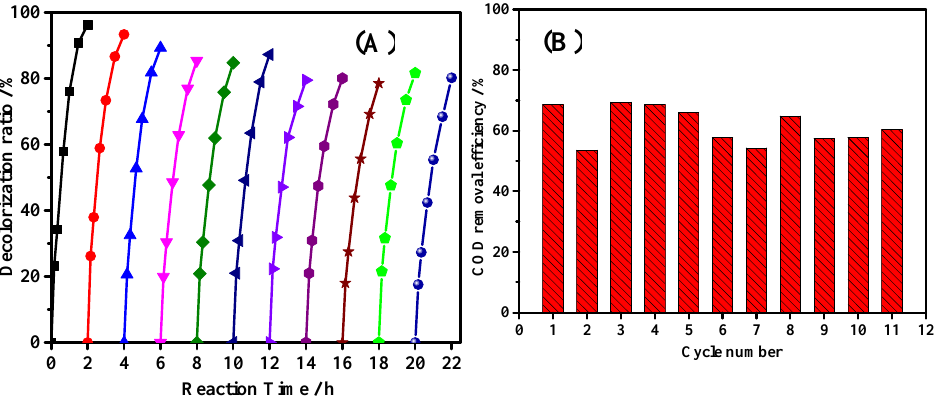
Figure 7. Stability of the catalytic activity ( A ) and the COD removal efficiency ( B ) during 11 repeats, C 0 (ARG) = 50 mg/L, C 0 (H 2 O 2 ) = 4 mM.